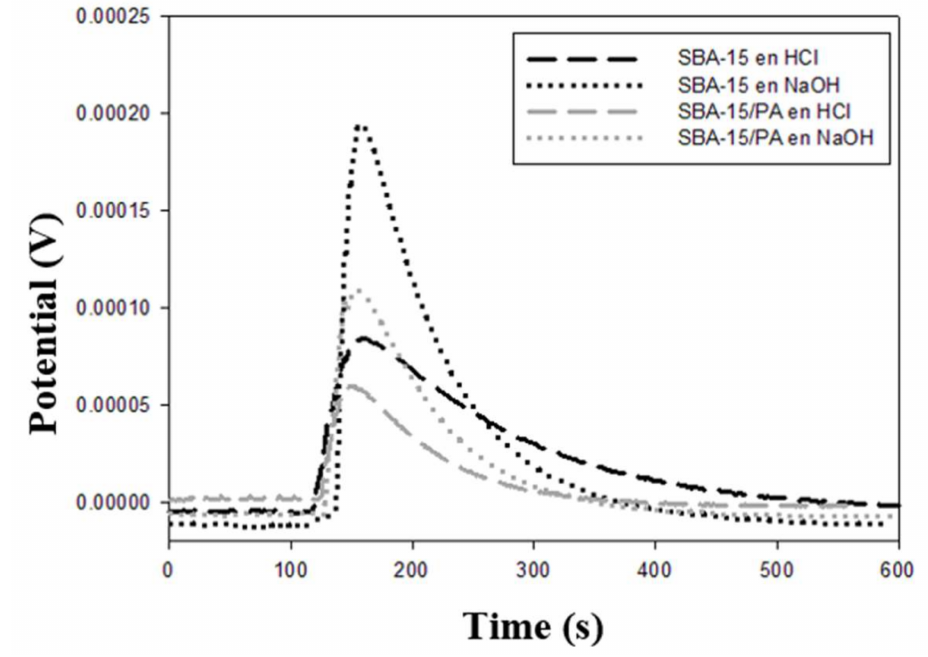
Figure 3. Immersion potentiogram for SBA-15 and its modification in HCl and